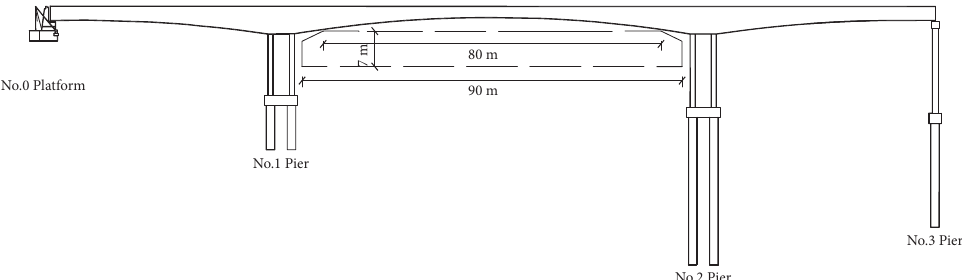
Figure 5: Layout of a bridge in